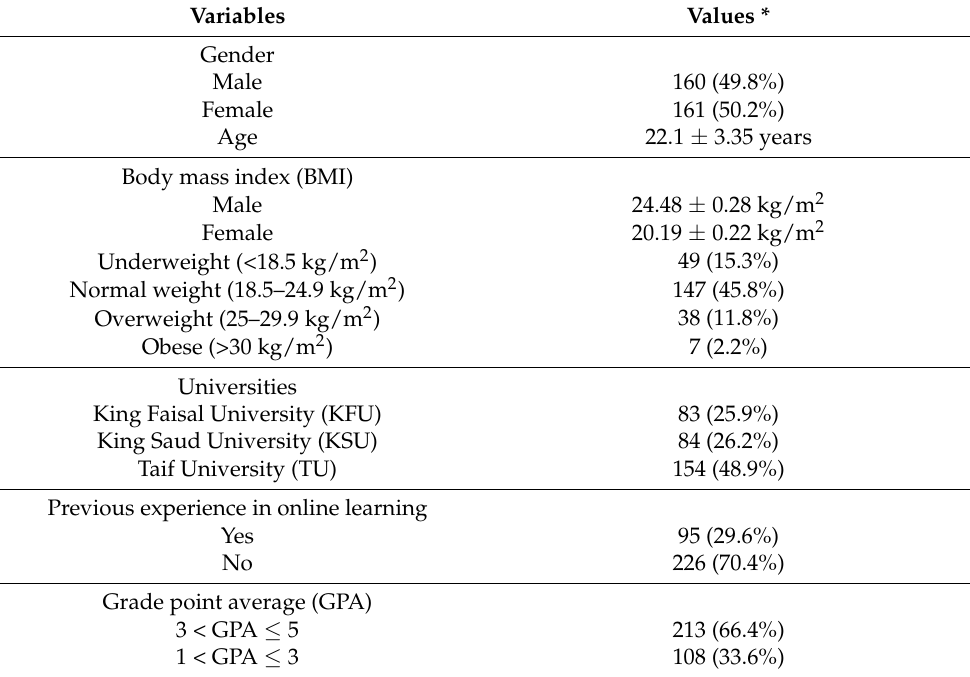
Table 1. Sociodemographic characteristics of the respondents ( n =